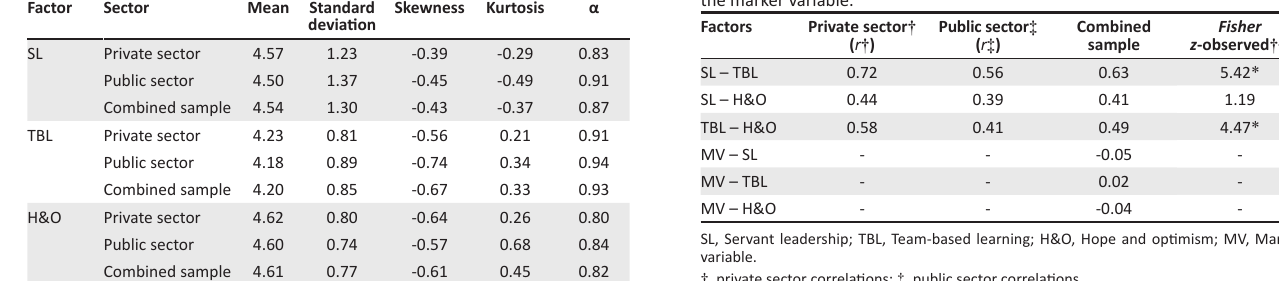
TABLE 4: Correlation between servant leadership, team-based learning and hope and optimism, the significance of the differences in the correlations, and the marker variable.